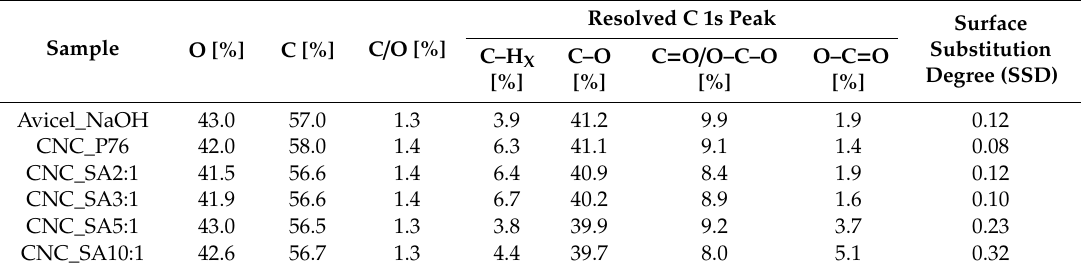
Figure 5. Resolved carbon C 1s peak for ( a ) CNC_P76 and surface modified CNCs at increasing molar ratio of succinic anhydride to cellulose hydroxyl groups: ( b ) CNC_SA3:1; ( c ) CNC_SA5:1; and ( d ) CNC_SA10:1. Table 2. Atomic concentrations from XPS spectra and a resolved carbon C 1s peak for alkali treated (CNC_P76) and surface modified CNCs at di ff erent molar ratio of succinic anhydride to cellulose hydroxyl